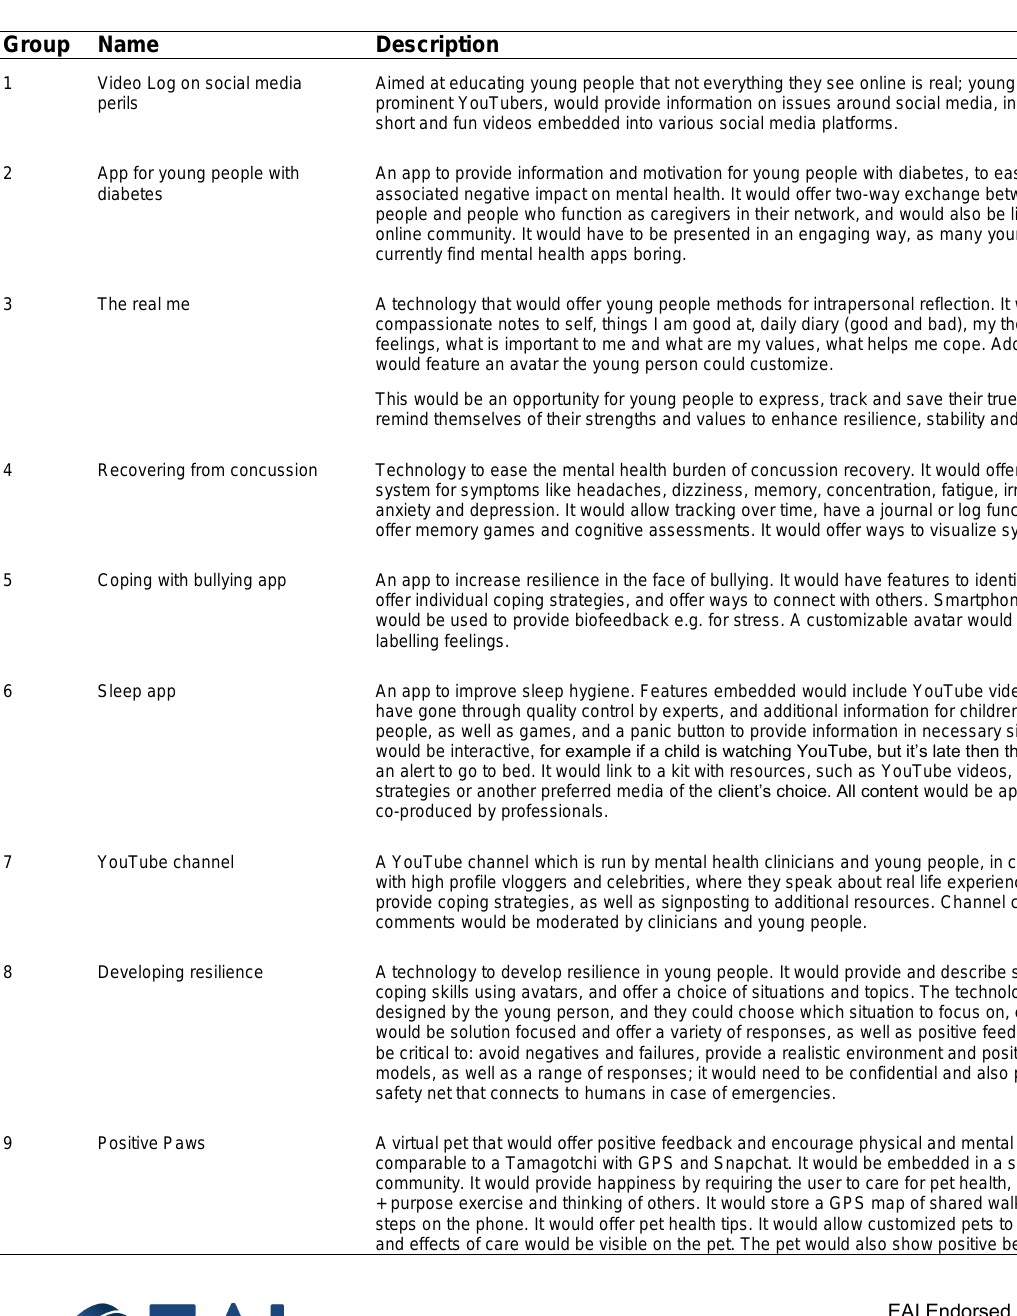
Table 2. Group concepts during British Psychological Society